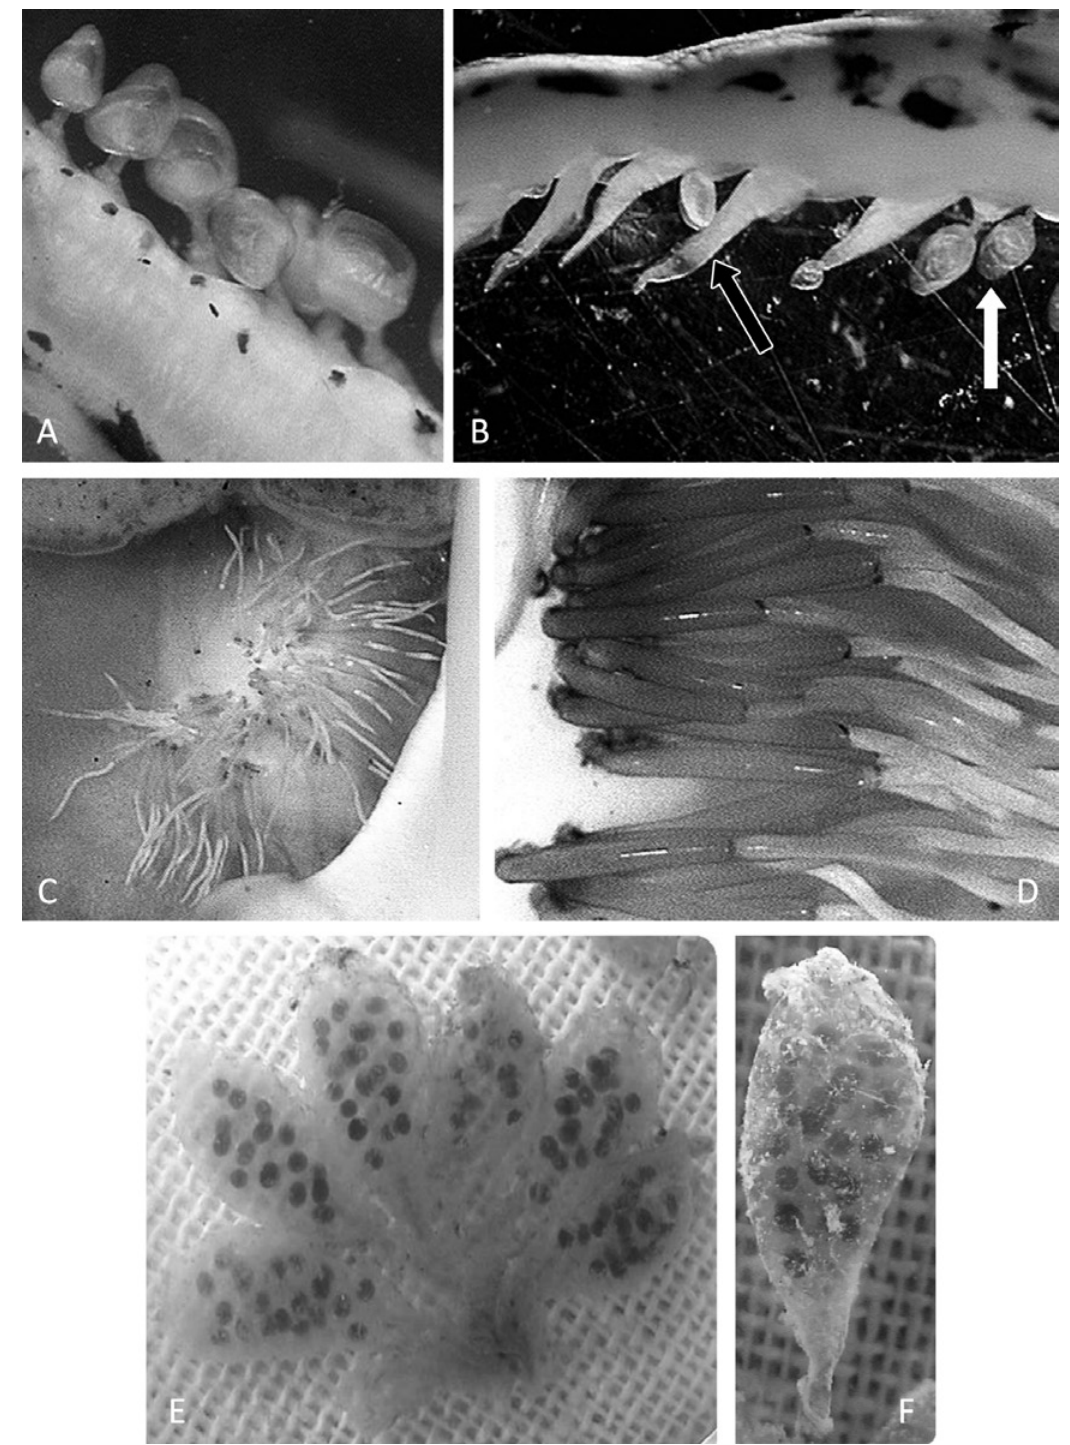
Figure 5 - Anatomical features of Lolliguncula brevis of Brazil. A- Suckers on second arm. B- Hectocotylus of male (white arrow: normal sucker and black arrow: modified sucker). C- and D- Spermatangias inserted in the inner mantle wall of a female. E- Egg mass, i.e., egg capsules fused by their peduncles into a common stalk. F- Detail of egg an